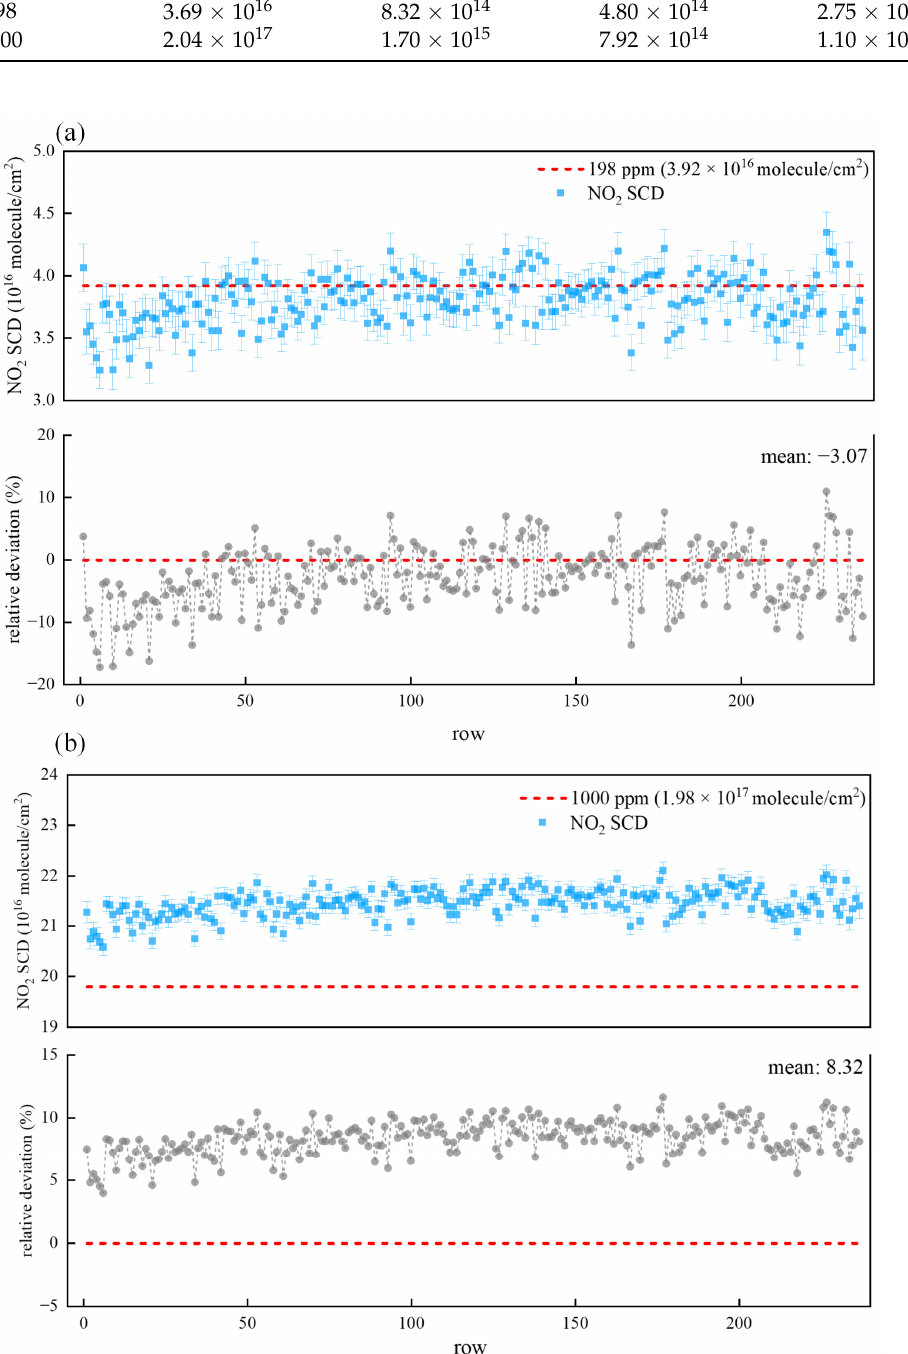
Figure 8. NO 2 SCD with fitting error and relative deviation of different spatial pixels of EMI-NL nadir module with integrating sphere and NO 2 sample gas concentrations of: ( a ) 198; and ( b ) 1000 ppm.